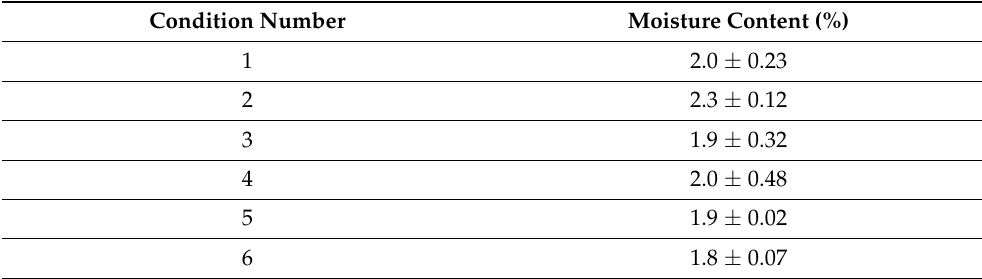
Table 3. Moisture content of CMC.BTA-MS obtained by different spray drying conditions.